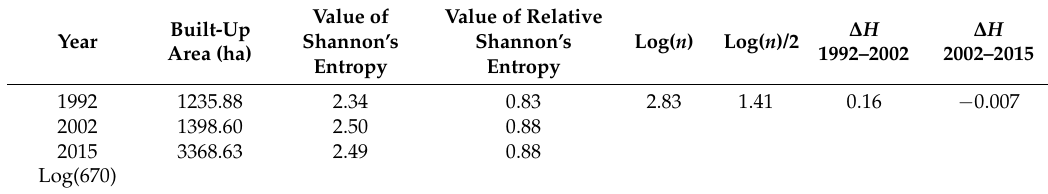
Table 7. Shannon’s entropy values for three years in the study area (MMFR